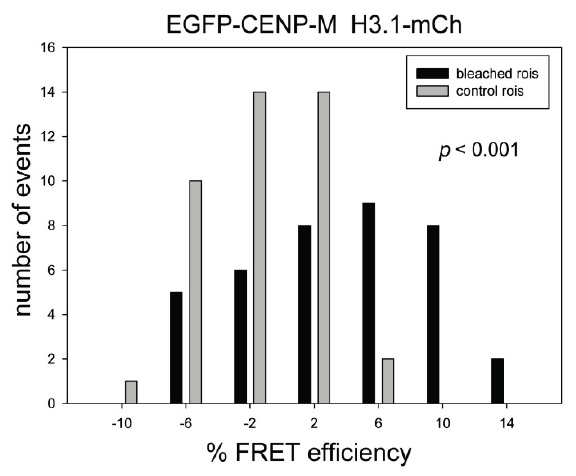
Figure 5. Acceptor-bleaching FRET between EGFP-CENP-M and H3.1-mCherry. The low p -value ( p < 0.001) indicates a strong FRET